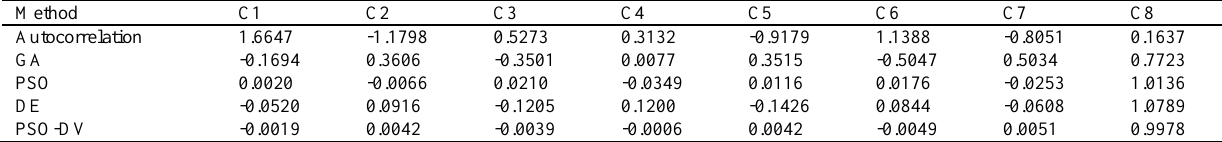
Table 5. LPC coefficients obtained by each method for frame 2.